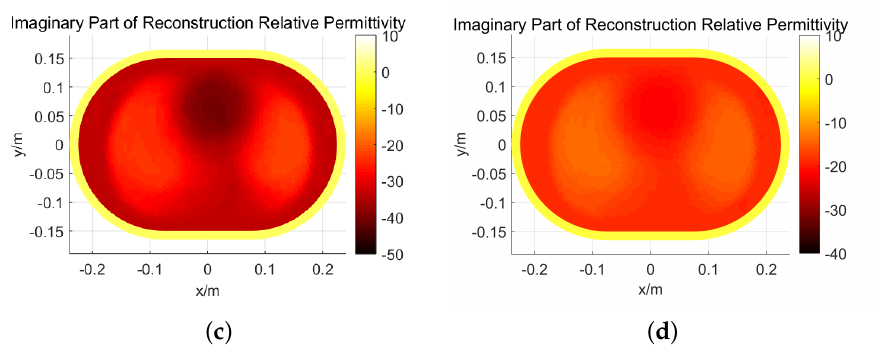
Figure 8. Reconstruction results of dual-frequency one-step supervised descent method (SDM): ( a , c ) 433 MHz; ( b , d ) 915